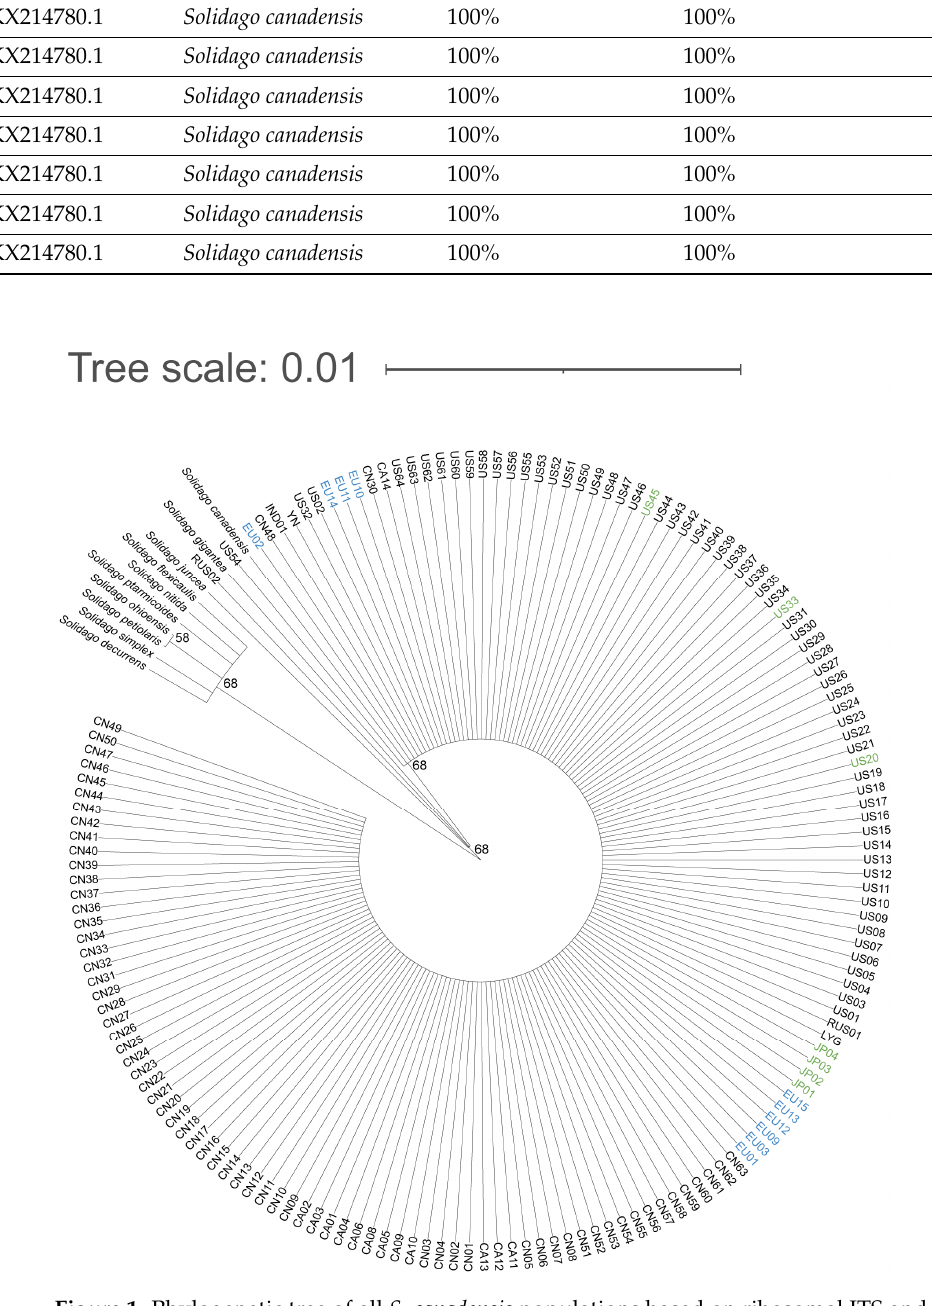
Figure 1. Phylogenetic tree of all S. canadensis populations based on ribosomal ITS and trn H- psb A intergenic spacer sequences. Blue represents Europe populations; green represents populations identified previously as S. altissima .